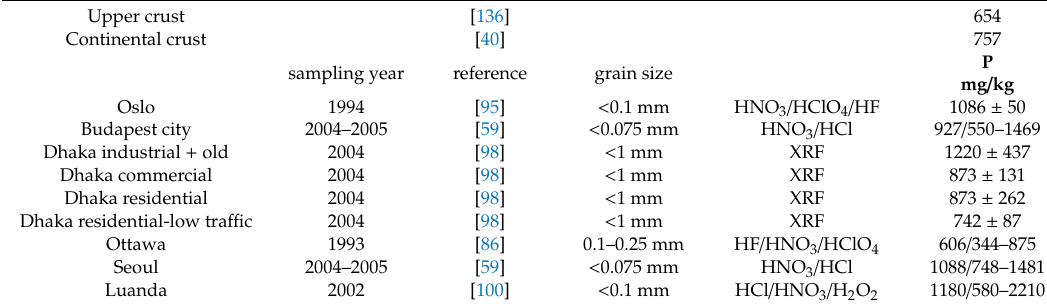
Table A34. Phosphorus in road dust.